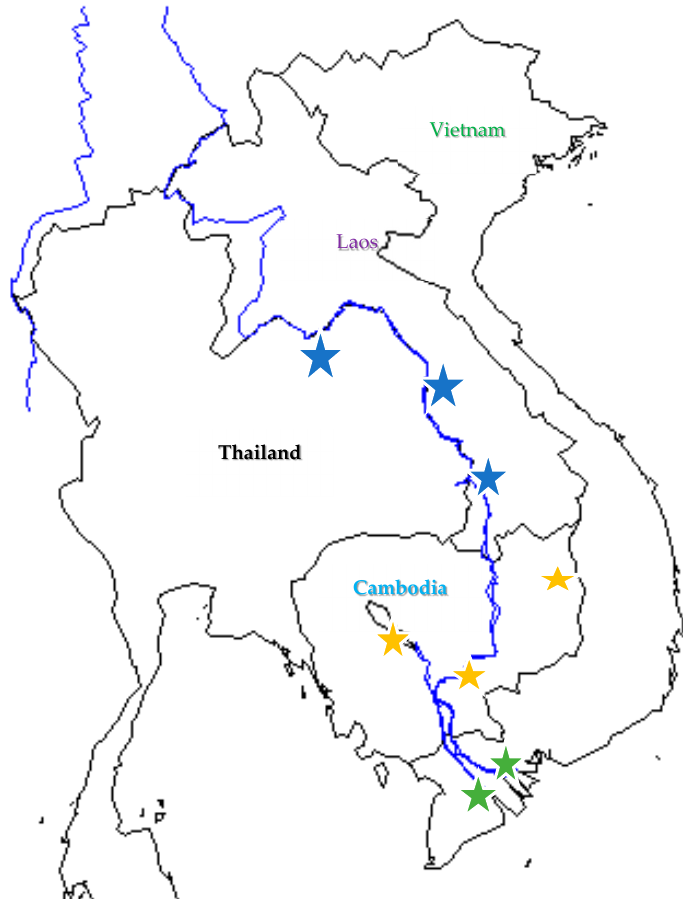
Figure 1. Sampling localities of samples of striped catfish across Thailand (blue star), Cambodia (yellow) and sampling clusters in Vietnam (7 locations each green star) along two main river branches of Mekong river (for details, please see Supplementary Table S1). This map was plotted by ‘ maps ’ and ‘ mapdata ’ packages in R.